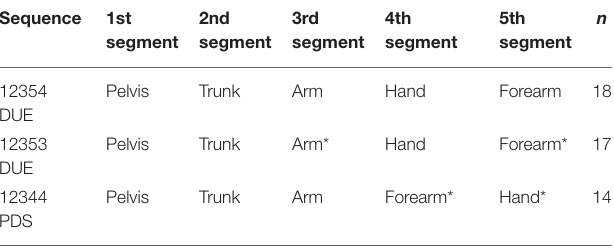
TABLE 4 | The three most performed kinematic sequences in this curveball pitch data set.